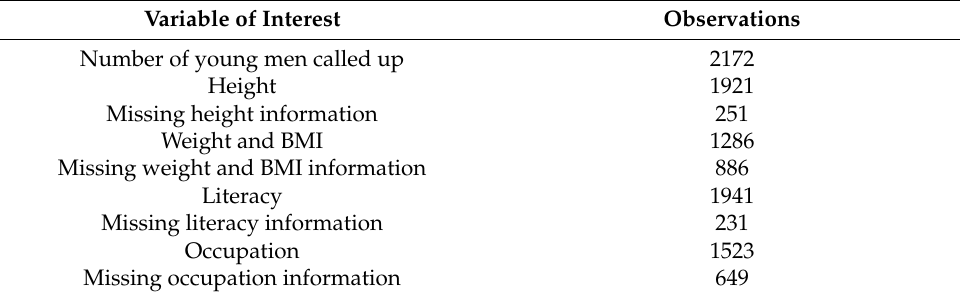
Table 1. Sample size by variable of interest. Variable of Interest